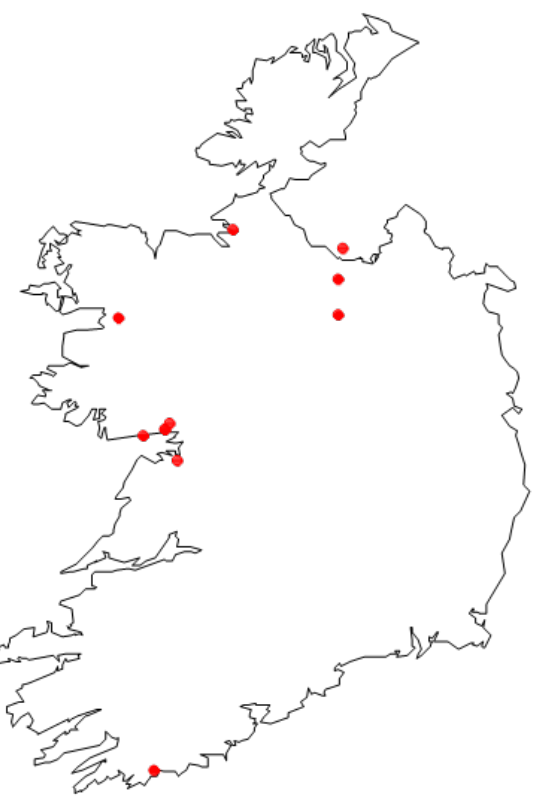
Figure 1. The 11 sampling sites used in the study around the west of Ireland. The closest two sites (Chapel and River Corrib) were 250m apart and so are not differentiated here.